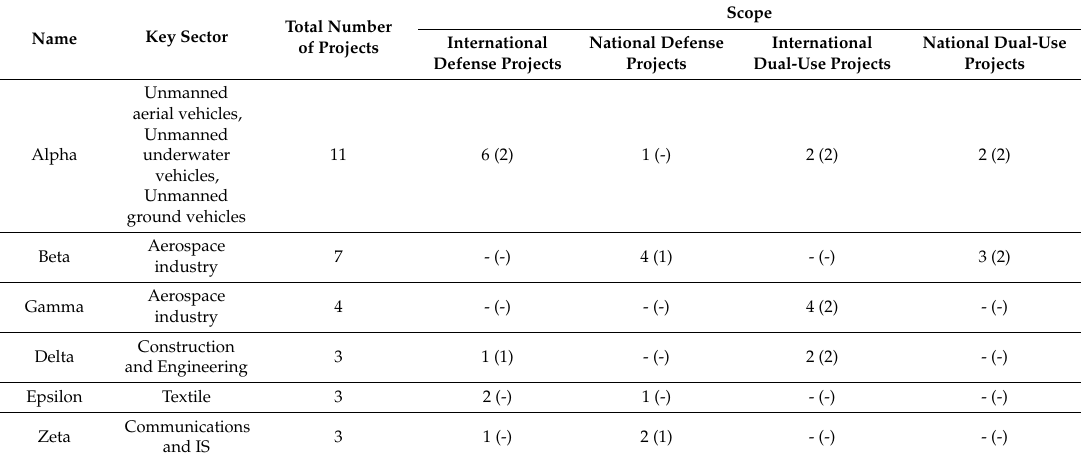
Table 4. Projects with participation and leadership roles involving Portuguese companies that participate in three or more projects.